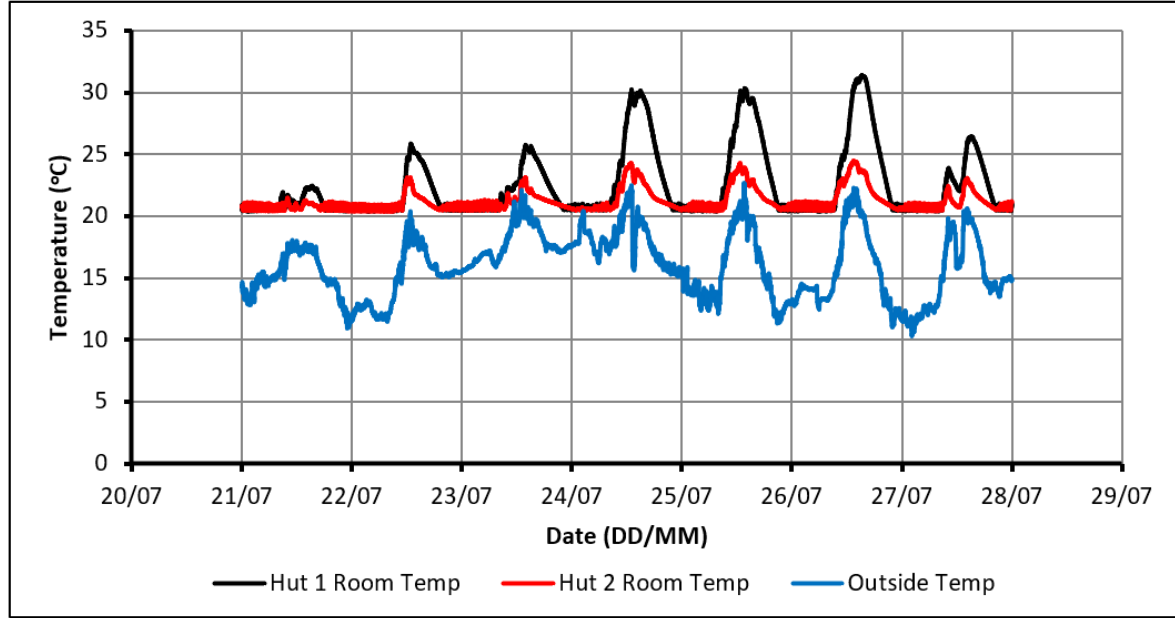
Figure 3. Temperature profiles in case of using passive solar heating and oil heater.